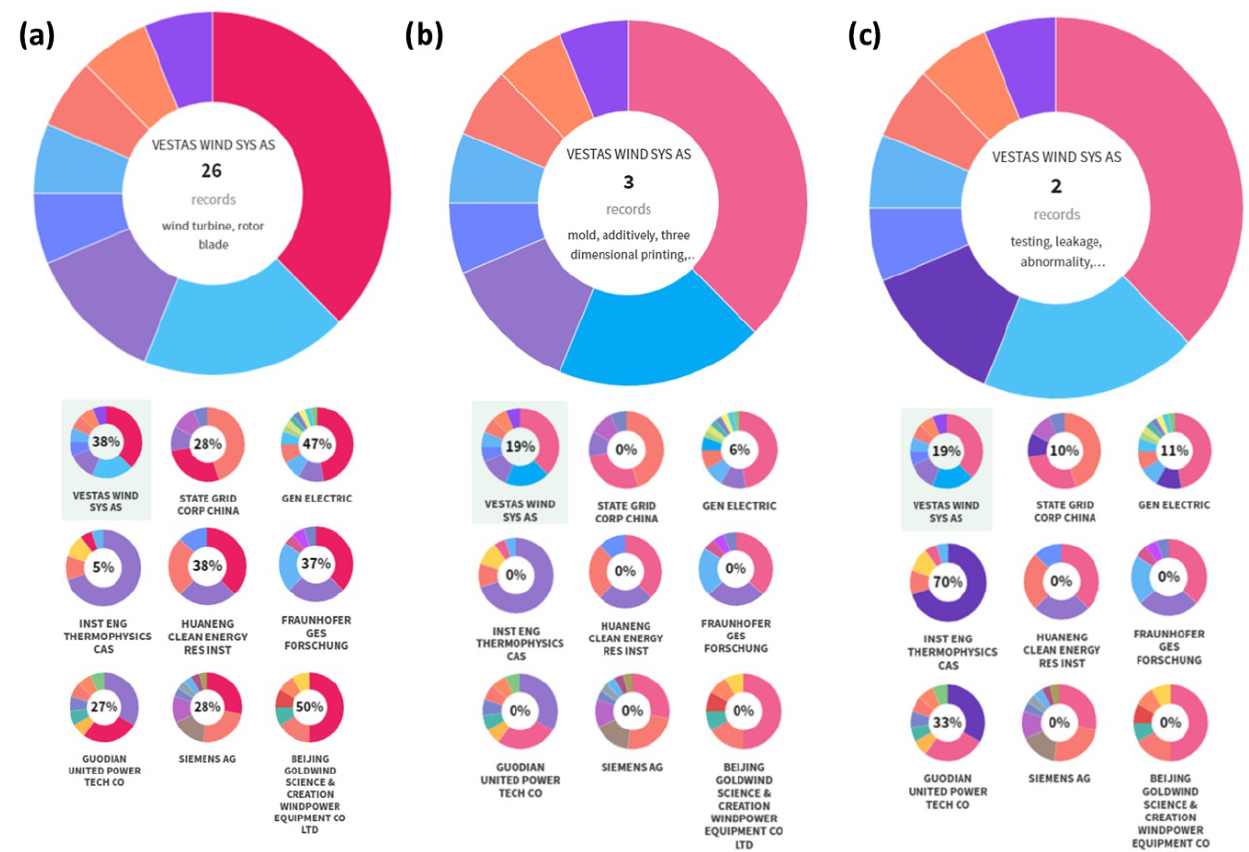
Figure 4. Analysis of the three main technological areas related to the inventions. Comparisons between the top filing company, Vestas Wind Sys As, and other companies, wherein (( a ), pink) refers to wind turbine, rotor, and blade; (( b ), blue) refers to additively, three-dimensional printing, additive, composite, build, and thermoplastic; (( c ), purple) refers to testing, leakage, abnormality, monitoring, sensor, detecting, and inspection. In the center of the larger donut chart is the number of patent documents of the main applicant for a given technology and, in the smaller donut charts, the percentage of companies involved in the production of inventions related to this technology. The technological area (b) in blue refers to “additively, three-dimensional printing, additive, composite, build, thermoplastic”, and (c) purple refers to “testing, leakage, ab- normality, monitoring, sensor, detecting, inspection”. The identified patent applications